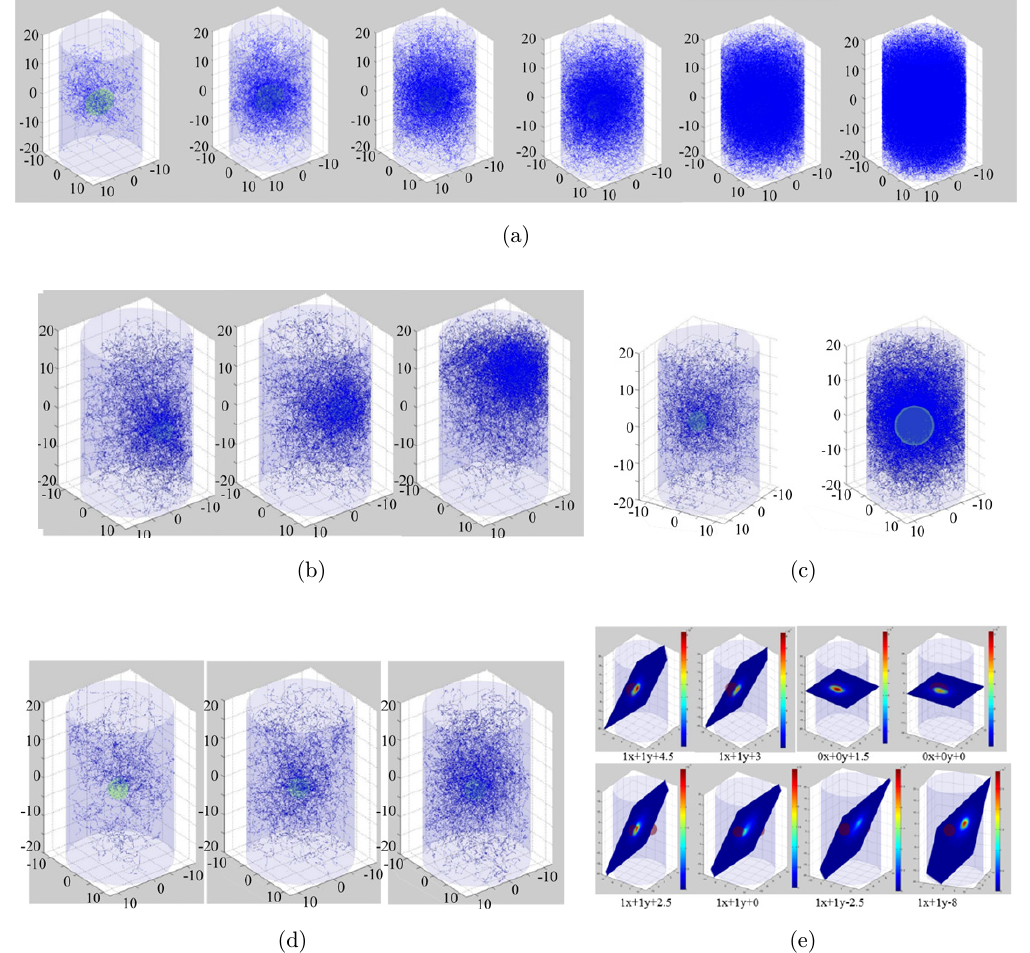
Fig. 5. A series of simulation experiments about °uorescence intensity distribution. (a) The relationship between the °uorescence intensity distribution and the excitation photon number. The excitation photon numbers are 100, 500, 1000, 2000, 5000 and 10,000, respectively. (b) The relationship between the °uorescence intensity distribution and the location of the °uorescence volumes. Coordinates are (5, (cid:1) 3, (cid:1) 5), (5, (cid:1) 3,0) and (5, (cid:1) 3,9), respectively. (c) The relationship between the °uorescence intensity distribution and the size of the °uorescent volume, size of spherical areas are (2.5,2), (5,2.5), and (5,5,5) respectively. (d) The relationship between the °uorescence intensity distribution and the anisotropy coe±cient. The values of are 0.3, 0.6, and 0.9, respectively. (e) Sectional view from various